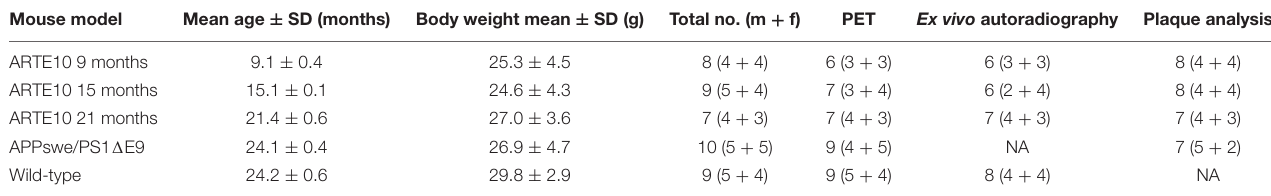
TABLE 1 | Overview of mice used for each analysis. Mouse